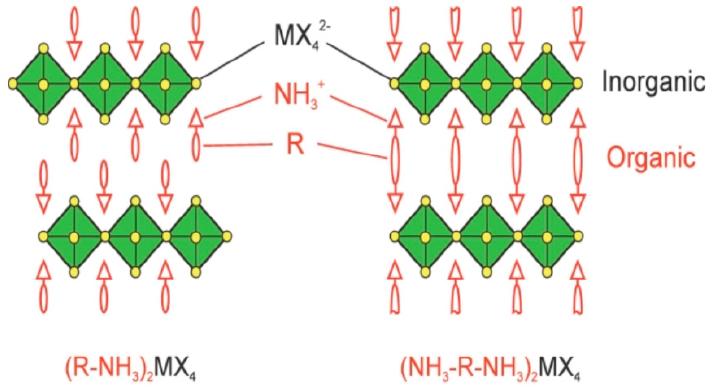
Figure 8. Schematic representation of low dimensional perovskite [90].